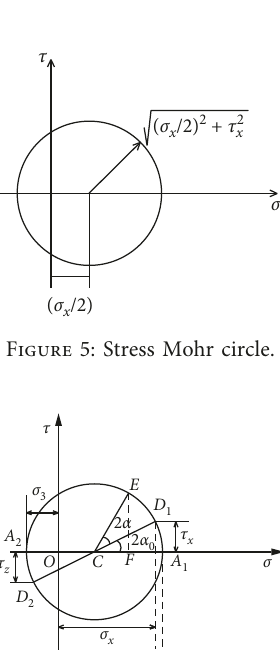
Figure 4: Schematic diagram of the stress state of the oblique section of the microelement body.